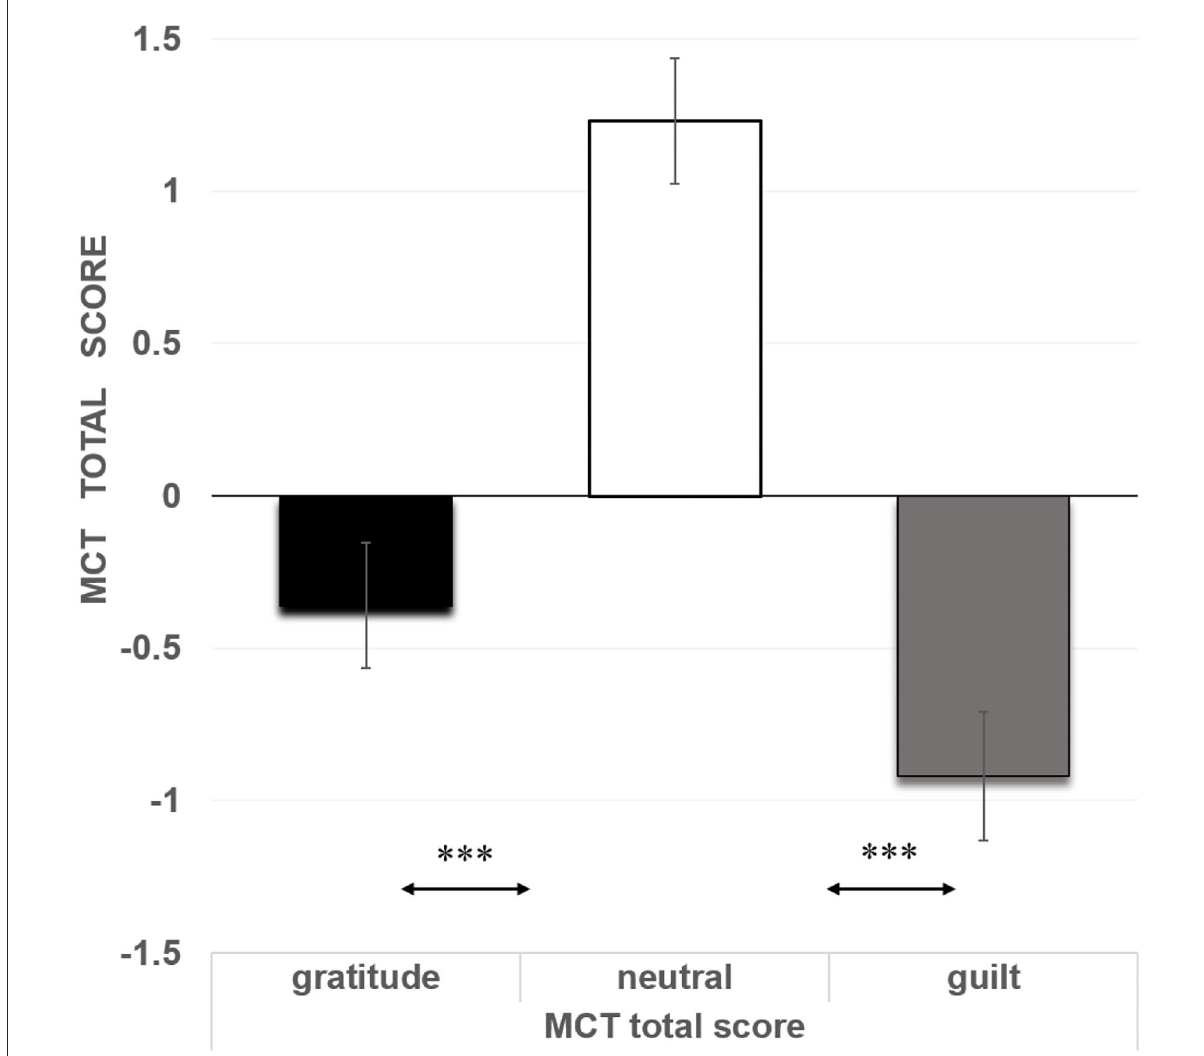
FIGURE2 Malevolent creativity The task total score in different emotion groups in experiment. The error bars represent standard errors. *** p < 0.001